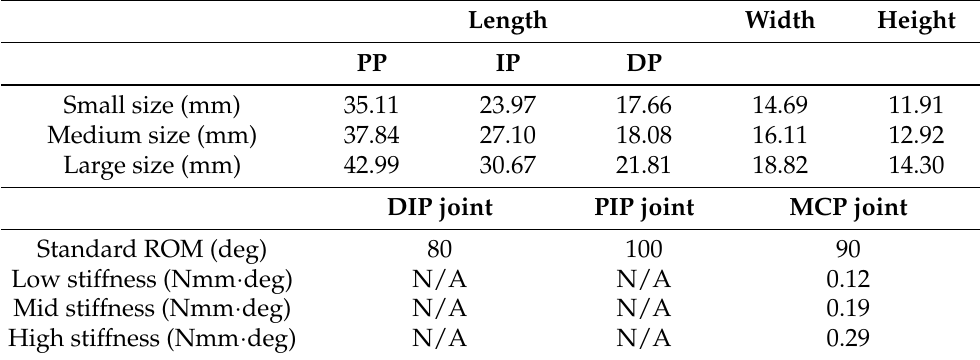
Table 1. Parameters of the individual